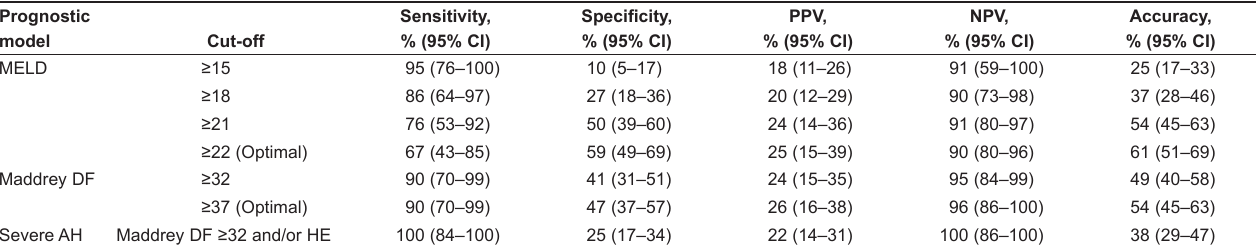
TABLE 4 Operating characteristics of Model for End-stage Liver disease (MELd) and Maddrey discriminant function (dF) for the prediction of 90-day mortality in patients hospitalized for alcoholic hepatitis (AH)